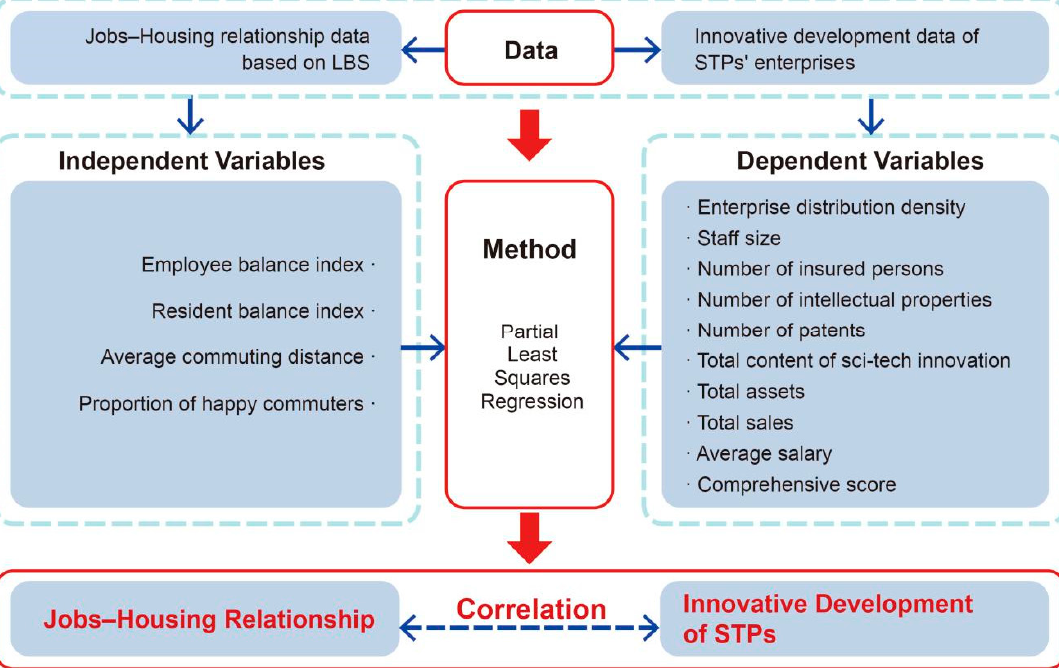
Figure 4. Flowchart of the methods.